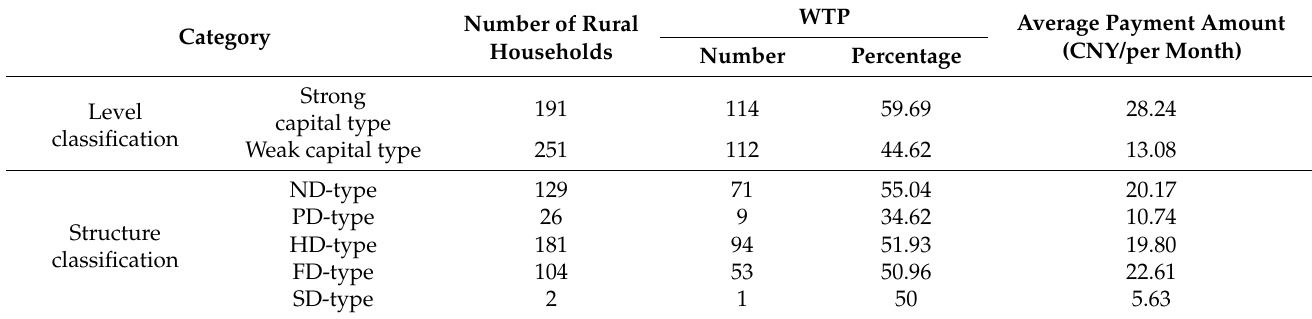
Table 6. Cross-analysis of livelihood capital and rural households’ WTP for